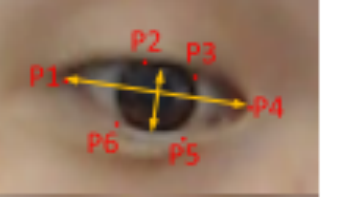
Figure 3. Facial extraction.